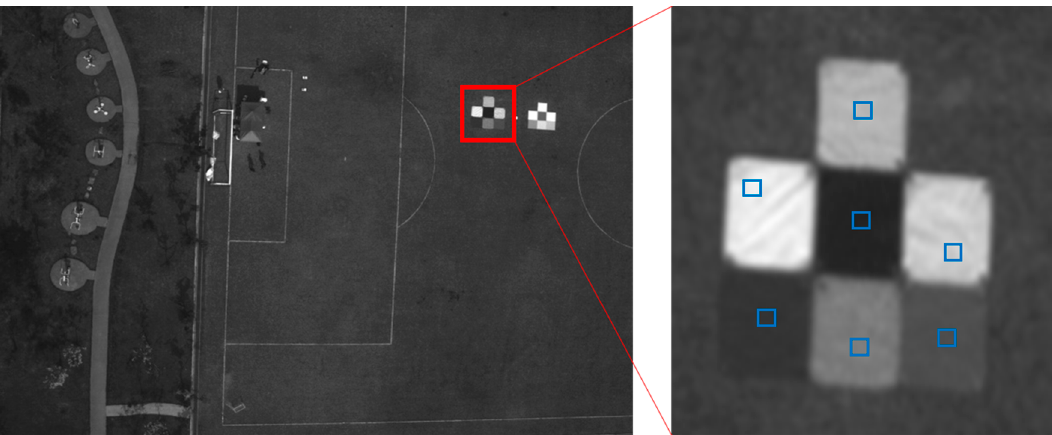
Figure 6. Example of a reference image with ground reference panels, and a close-up of the reference panels where blue boxes are locations of sample pixels used for vicarious calibration.